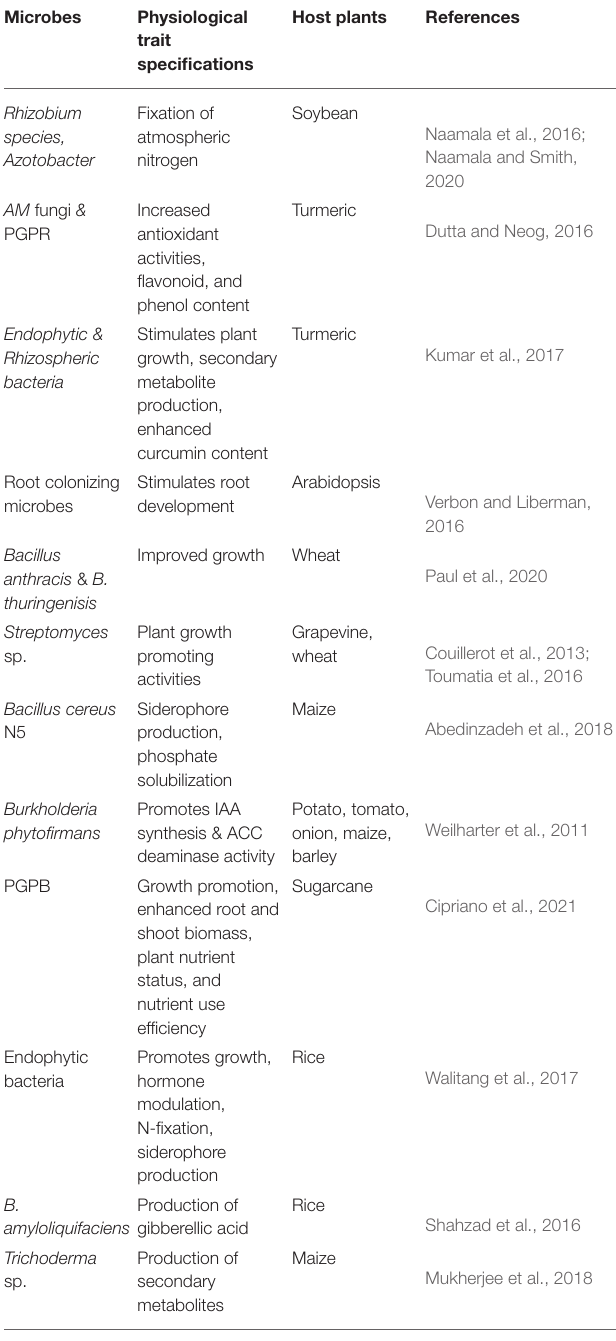
TABLE 4 | Role of microbes in plant physiological